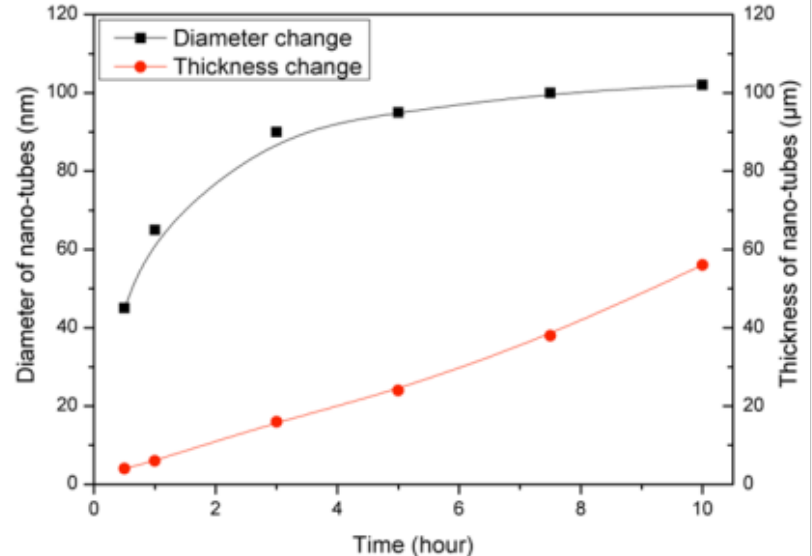
Figure 3. Measured layer thickness and surface diameter of the obtained TiO EG-based solutions depending on anodization